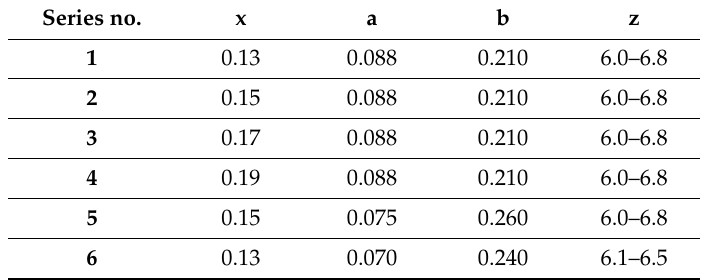
Table 1. Chemical composition of the experimental alloys Sm 1-X Zr X (Co 1-a-b Cu a Fe b ) Z . Series no. x a b